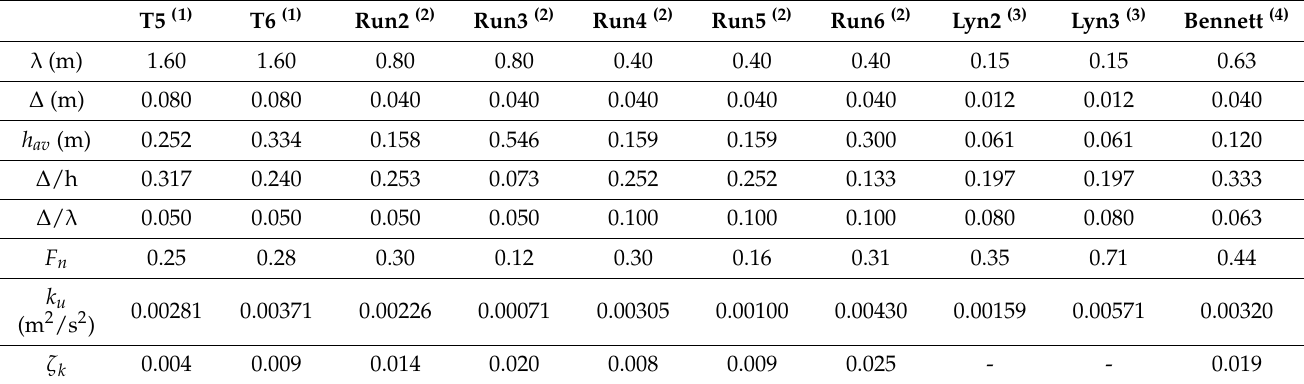
Table 1. Summary of the geometrical and flow parameters of selected fixed-bedform experiments reported in the